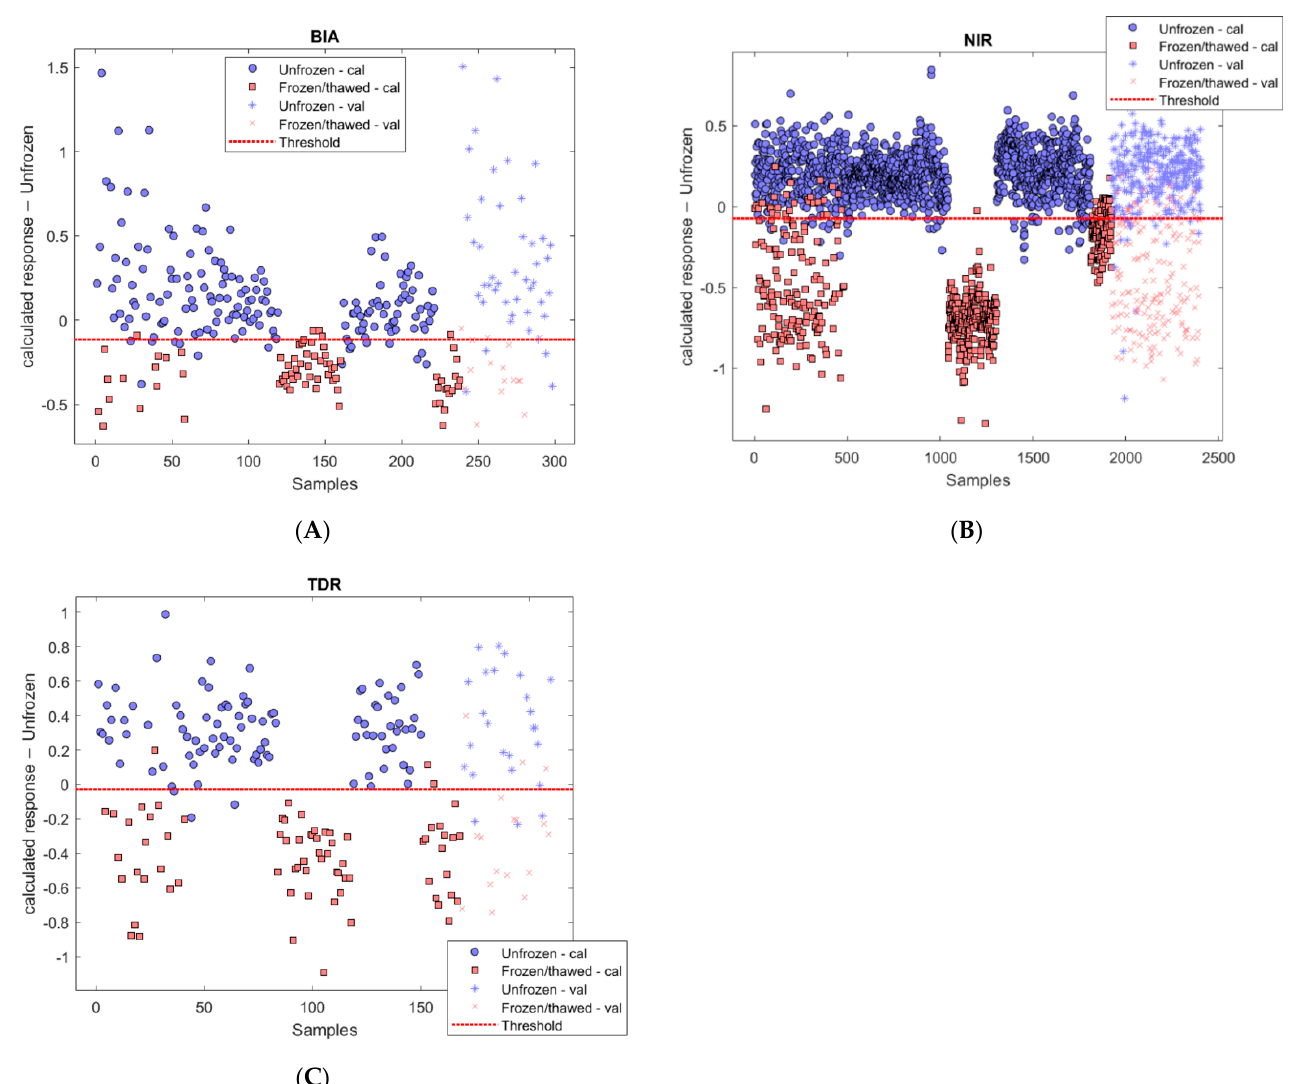
Figure 1. Calculated response for class unfrozen in: BIA ( A ), NIR ( B ) and TDR ( C ). In the calibration set, unfrozen samples are represented with circles and frozen-thawed samples with squares. In the validation set, unfrozen samples are represented with + and frozen-thawed samples with x. “Cal” and “Val” mean samples used for calibration and validation, respectively. BIA: bioelectrical impedance snalysis. NIR: near-infrared spectroscopy. TDR: time domain re-flectometry.